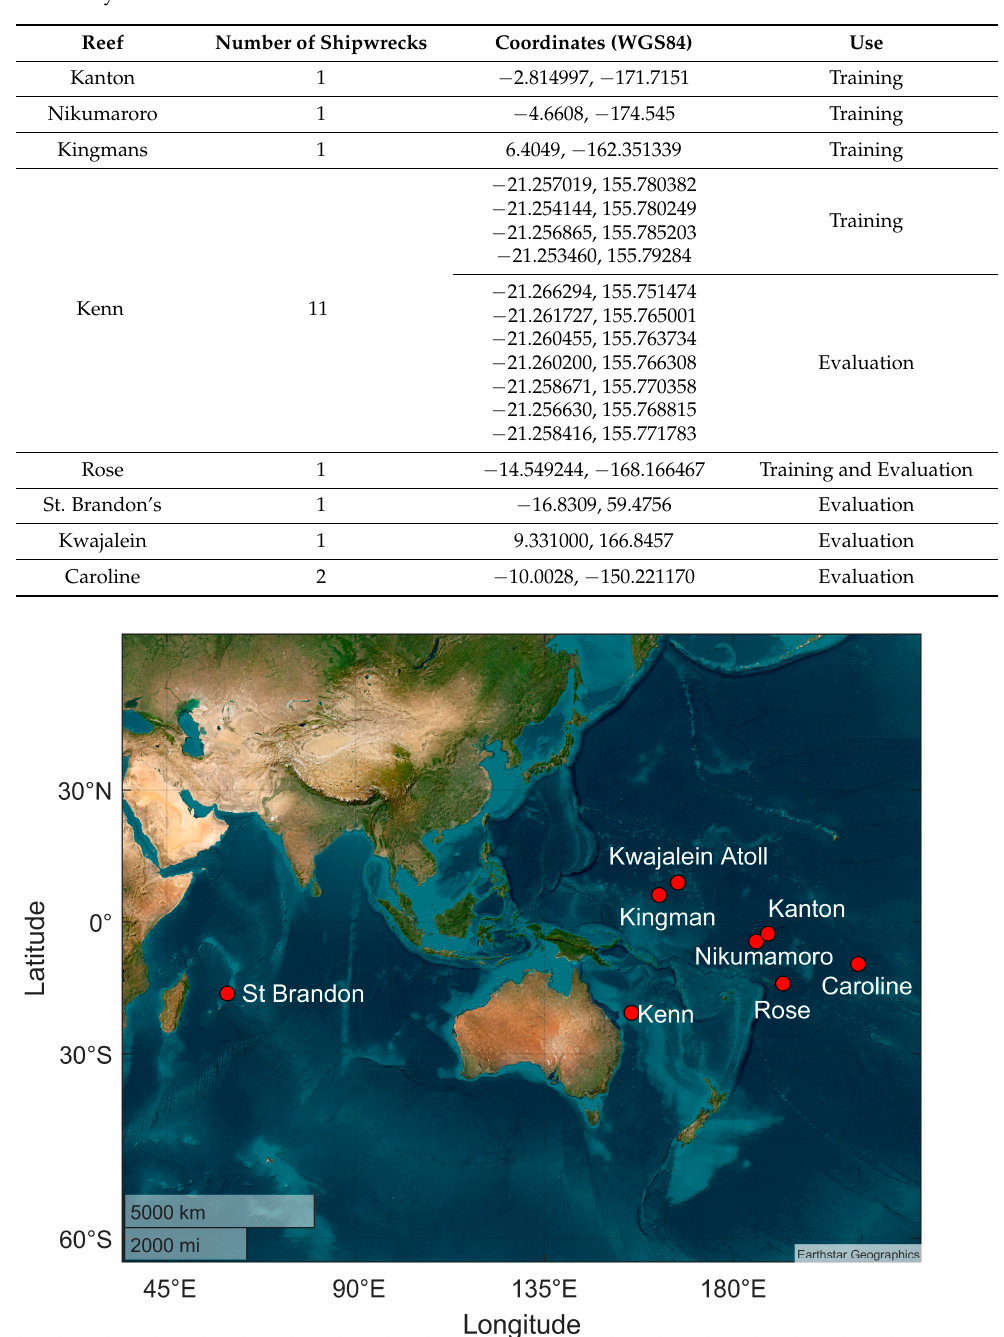
Figure 1. Map showing the locations of the reefs investigated in this work.